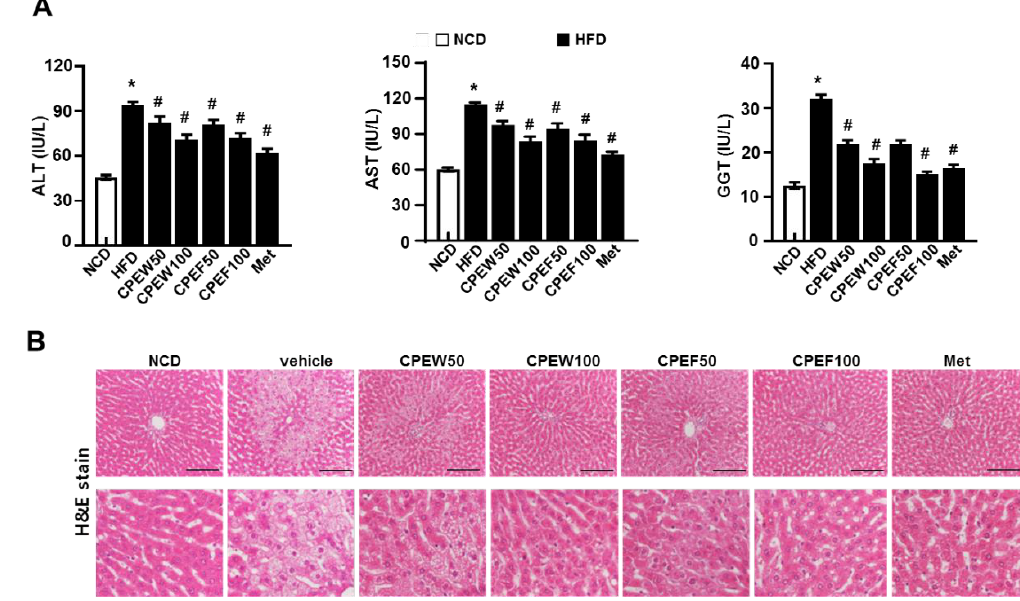
Figure 2. Citrus peel extract protects against HFD-induced hepatic functional damage . Rats were placed on either an NCD or 60% high-fat diet for eight weeks and were supplemented with ultra-pure water, metformin (100 mg/kg), or one of the indicated concentrations of citrus peel (50 and 100 mg/kg). ( A ) AST, ALT, and GGT were measured in HFD-fed rats. ( B ) H&E staining assay was performed using the liver (100 × magnification). Values are mean ± SEM. ( n = 7~8, * P < 0.05 vs. NCD-group, # P < 0.05 vs. HFD-group). CPEW, citrus peel extract hot-air dry; CPEF, citrus peel extract freeze-drying; ALT, alanine aminotransferase; AST, aspartate aminotransferase; GGT, gamma-glutamyl transferase; HFD, high-fat diet; NCD, normal calorie diet.